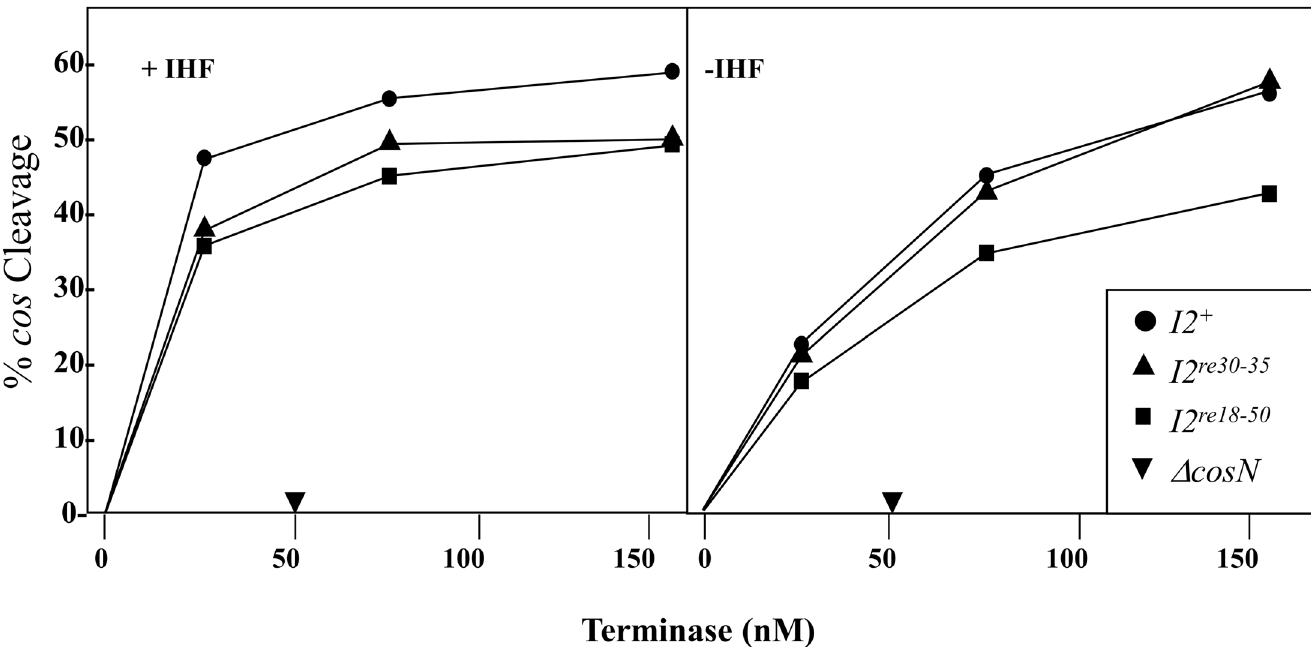
Fig 6. Effect of I2 mutations on in vitro cos cleavage. I2 -containing 2.9 kb pOER1-5 DNAs (Table 2), linearized with AatII, were used as cos -cleavage substrates. After heating at 70°C for 10 min, to melt cohesive ends the 0.6 (L) and 2.3 (R) kb reaction products were run on agarose gels and stained with ethidium bromide. Band intensity was measured with a Typhoon phosphoimager. Reactions were done in the presence (left panel) and absence (right panel) of IHF (see Materials and Methods).